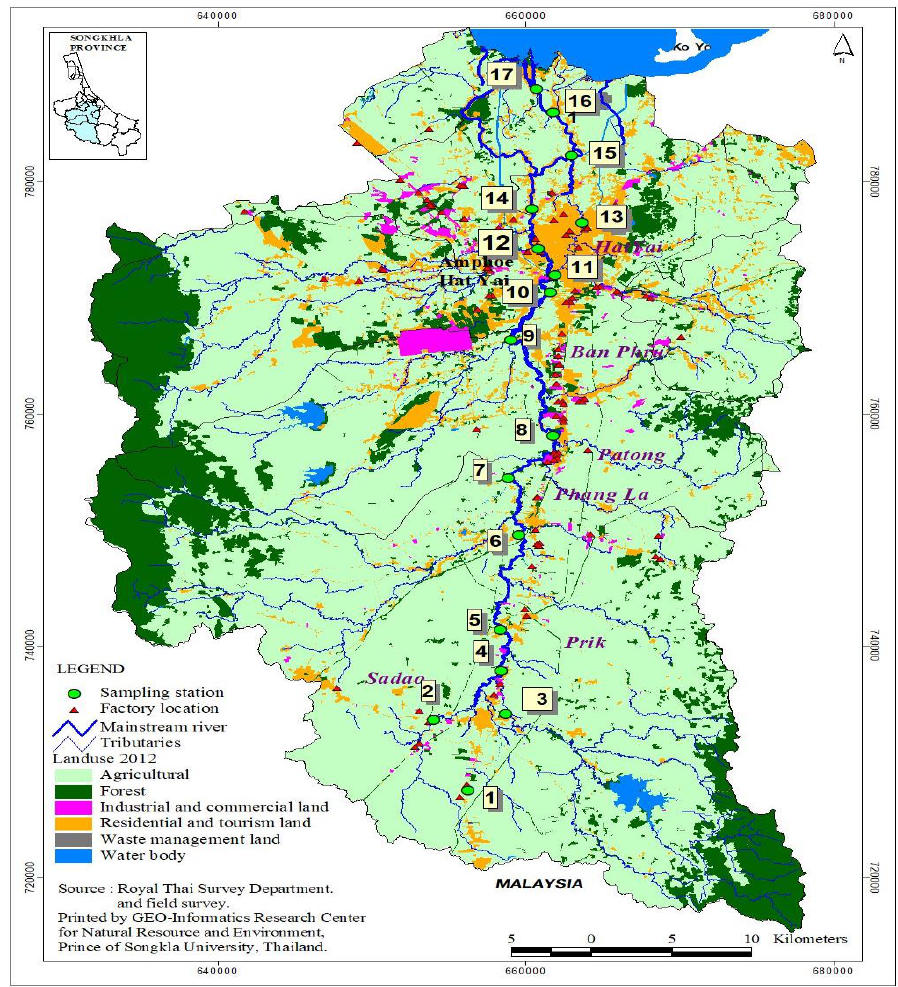
Figure 1. Map showing sampling sites for surface water of the U-Tapao canal. Source (Geoinformatics research center, Prince of Songkla University, 2019).